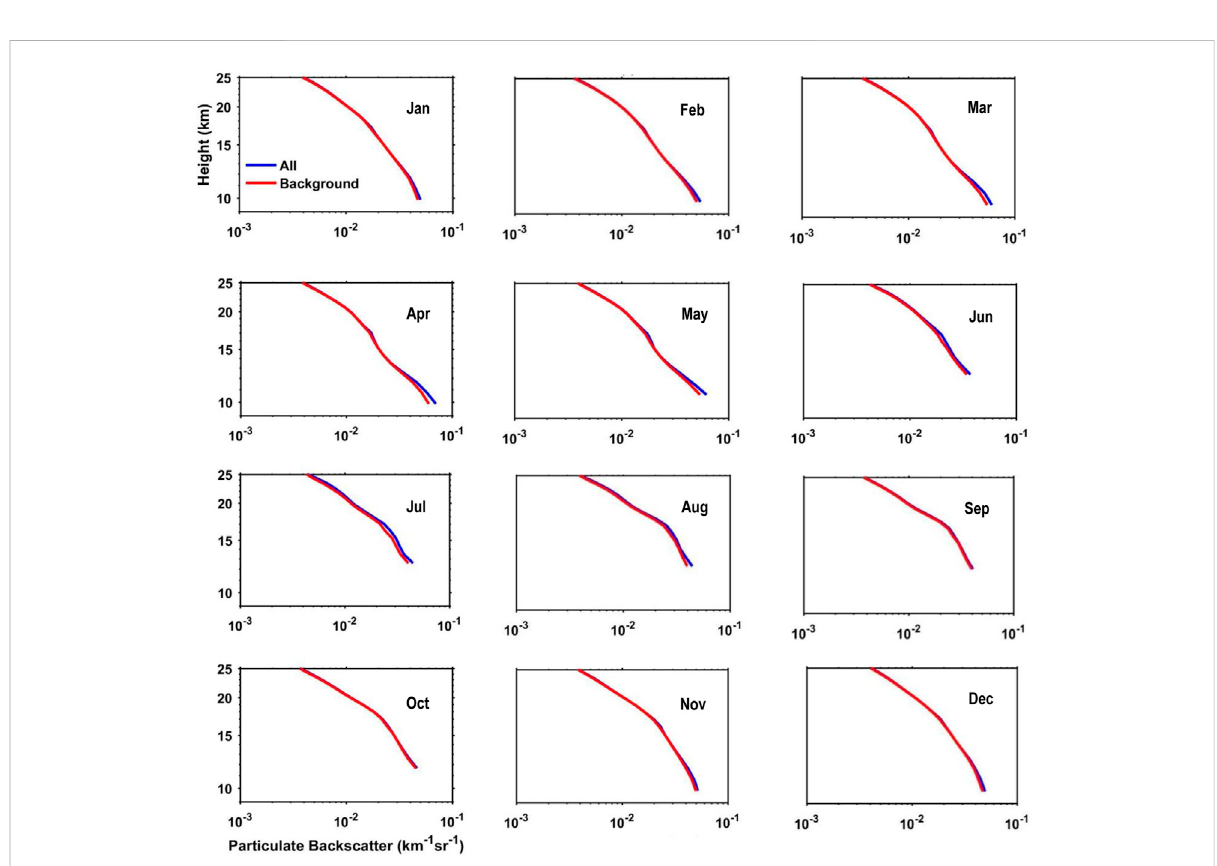
FIGURE 6 Vertical pro fi le of monthly mean background and total aerosol particulate backscattering ratios in the stratosphere over Xinjiang from 2007 to 2018 retrieved from